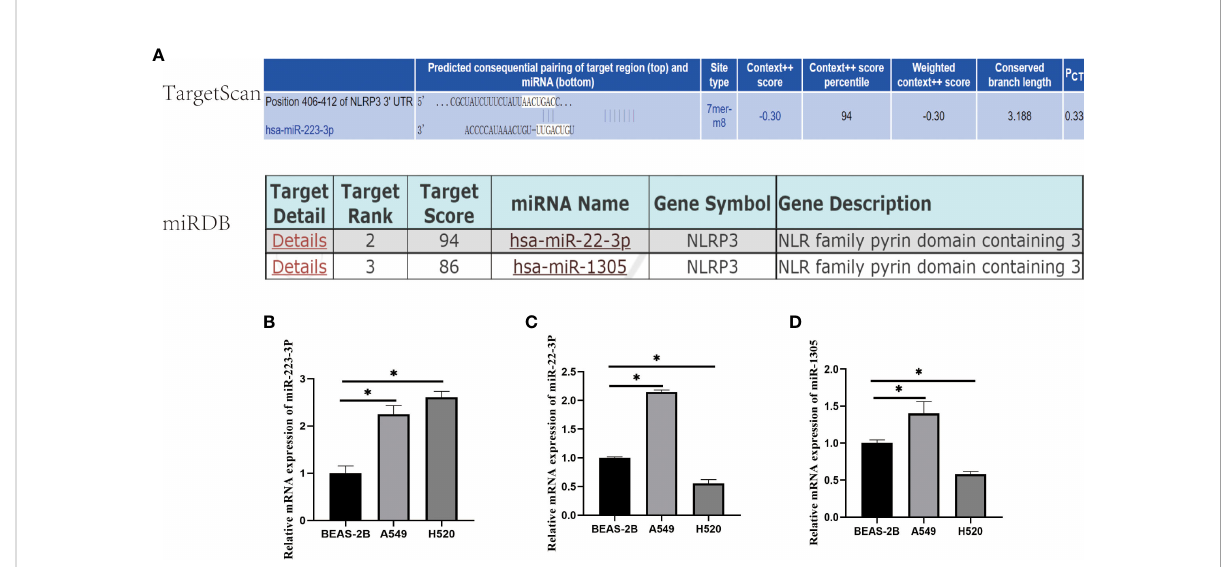
FIGURE 1 The selection and expression of miRNAs regulating NLRP3. (A) The target score of the selected miRNAs binding to NLRP3 gene. miR-223-3p was selected from TaargetScan Database with P CT ≧ 0.3; miR-22-2p and miR-1305 were selected from miRDB Database with predicted target scores >85. (B) The relative expression of miR-223-3p. (C) The relative expression of miR-22-3p. (D) The relative expression of miR-1305. Data were presented as means ± SD of three independent experiments. * P